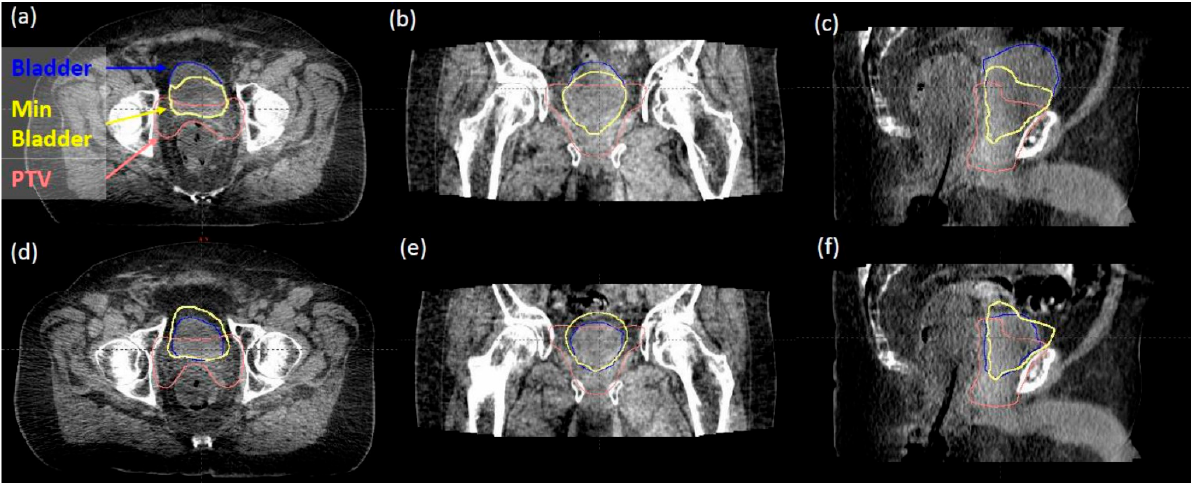
Figure 4. ( a – c ) an example of a daily bladder volume that passed the V65% >60% constraint. The bladder (blue) extends anteriorly and superiorly beyond the “minimum bladder” contour (yellow). ( d – f ) An example of a daily bladder volume that failed the V65% >60% constraint. The bladder does not completely extend anteriorly and superiorly beyond the “minimum bladder” contour.